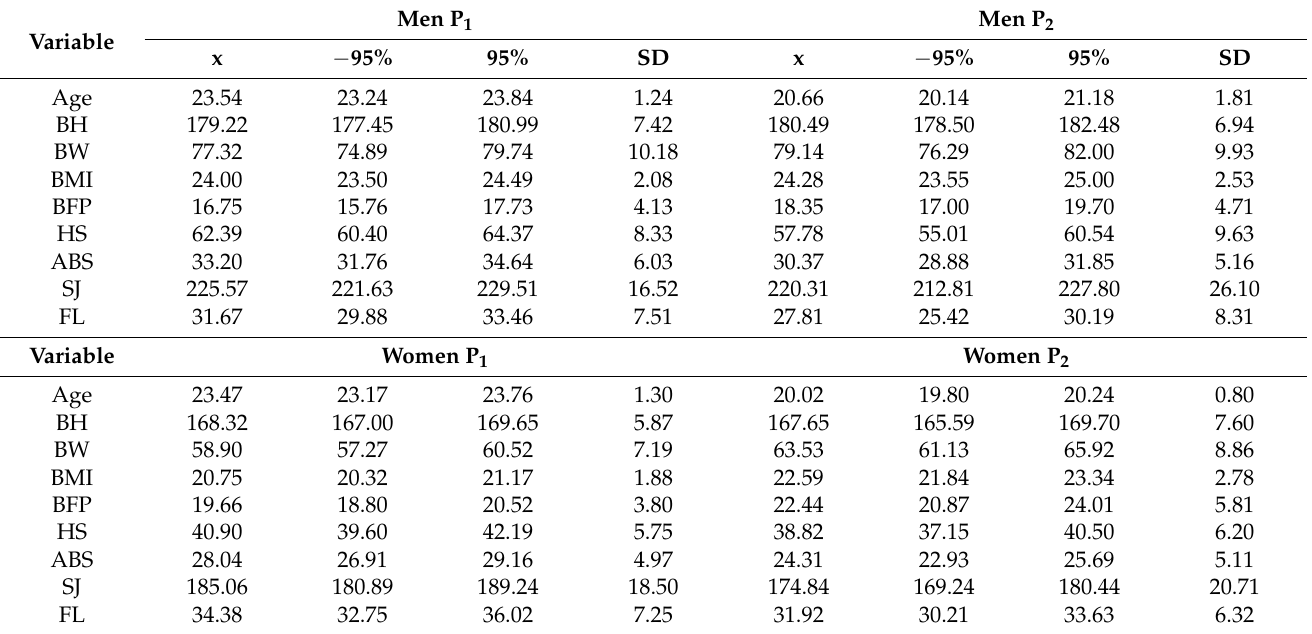
Table 2. Descriptive statistics of the measured parameters in periods and sex